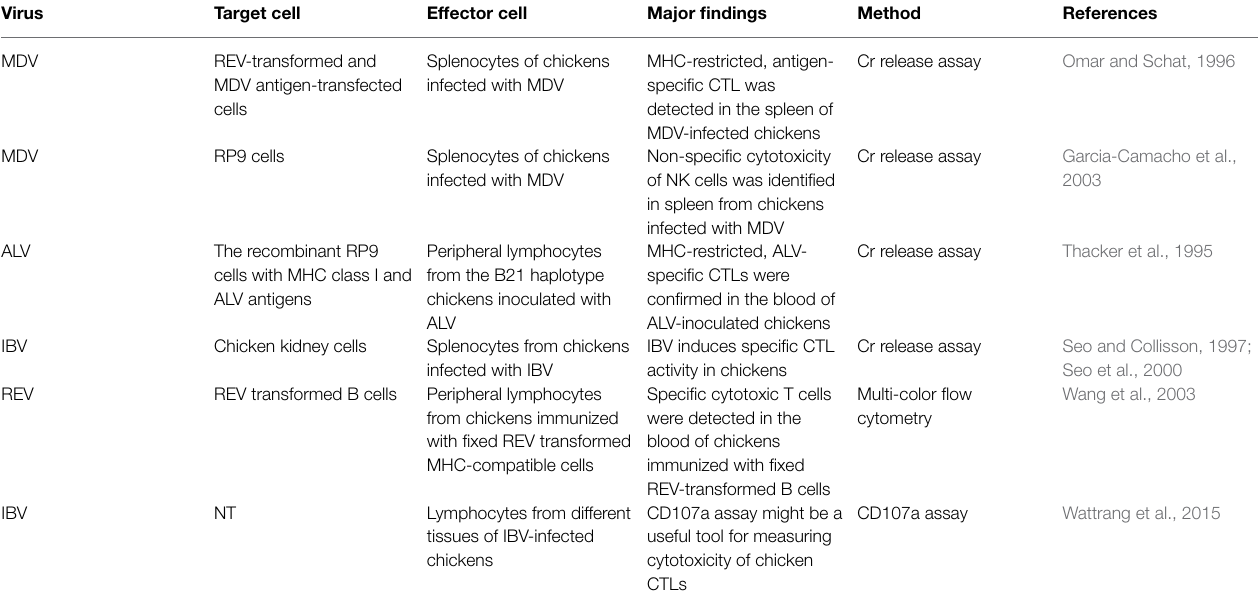
TABLE 4 | Cell-mediated cytotoxicity was measured in avian virus